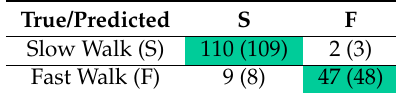
Table 3. Confusion matrix obtained applying SVM and kNN (into parentheses) on two classes, considering 5 principal components, acc = 93.5%.